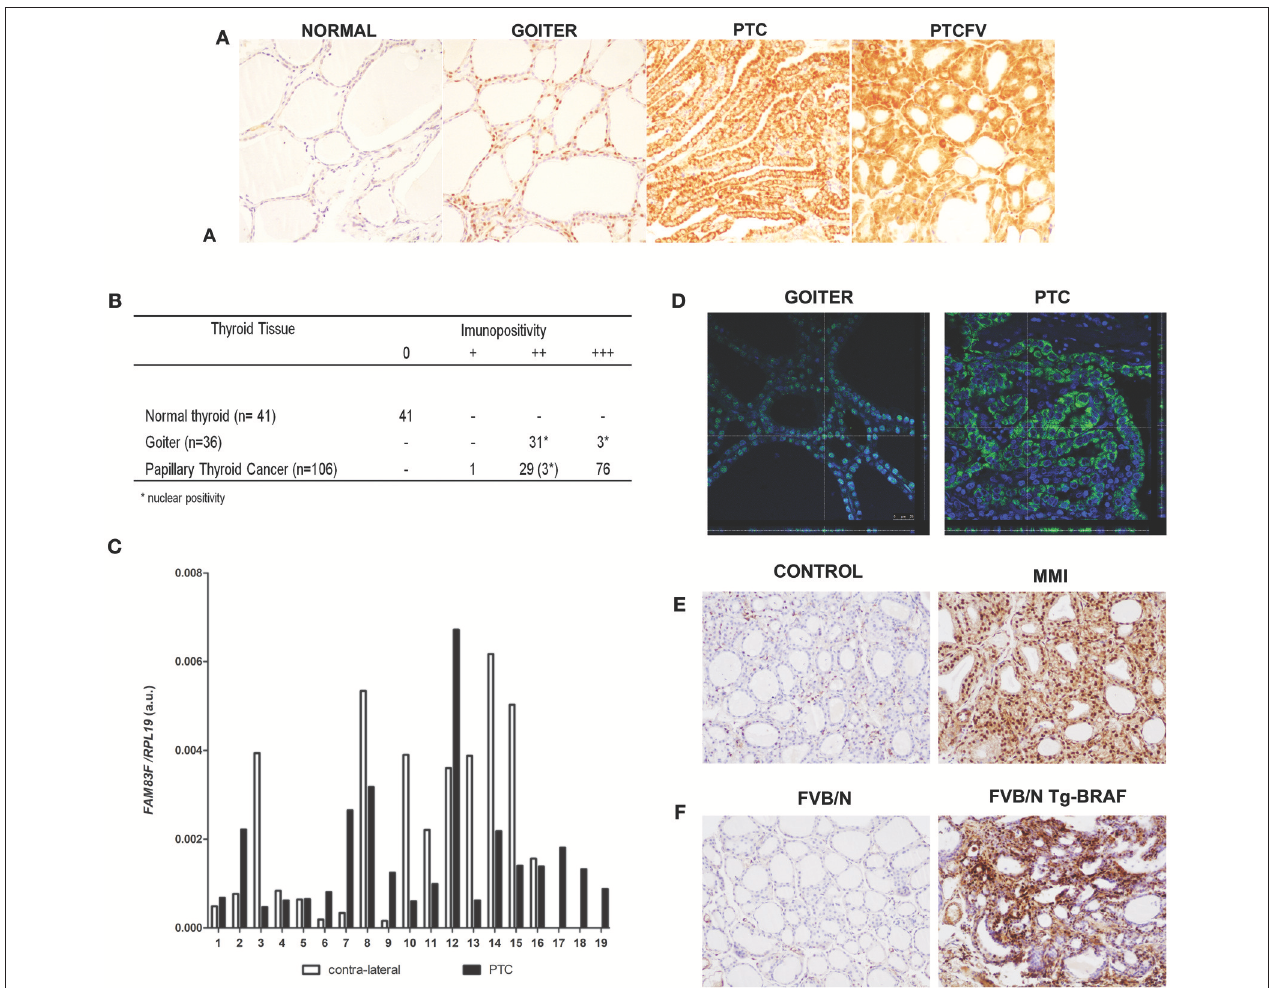
FIGURE 1 | FAM83F protein expression in human thyroid tumors and in animal models. (A) Detection of FAM83F using IHC shows strong cytoplasmic expression in papillary thyroid cancer (PTC), while in goiter strong nuclear expression is detected. Normal adjacent thyroid tissue is mostly negative for FAM83F staining. (B) IHC quantification in PTC ( n = 106), goiter ( n = 34), and normal thyroid tissue ( n = 41). (C) FAM83F gene expression in a set of 19 paired human PTC vs. contra-lateral thyroid tissue by qPCR. Data shown as relative expression of FAM83F/RPL19 . (D) Confocal microscopy of FAM83F in goiter and PTC. Immunofluorescence staining of FAM83F protein in goiter section (left panel) shows nuclear localization observed in the z-stack that colocalizes the nucleus with the green fluorescence of FAM83F, while in PTC section (right panel) FAM83F expression is cytoplasmic. (E) FAM83F protein expression in rat-induced pharmacological goiter. The treatment of rats with MMI for 5 days increased immunopositivity of FAM83F in thyroid follicular cells with strong positivity in the nucleus and mild positivity in cytoplasm ( n = 5). (F) FAM83F protein expression in BRAF T 1799 A transgenic mice with PTC. Detection of FAM83F using IHC shows strong cytoplasmic and nuclear expression in 5–weeks old mice PTC ( n = 5), while no expression is observed in normal thyroid ( n =